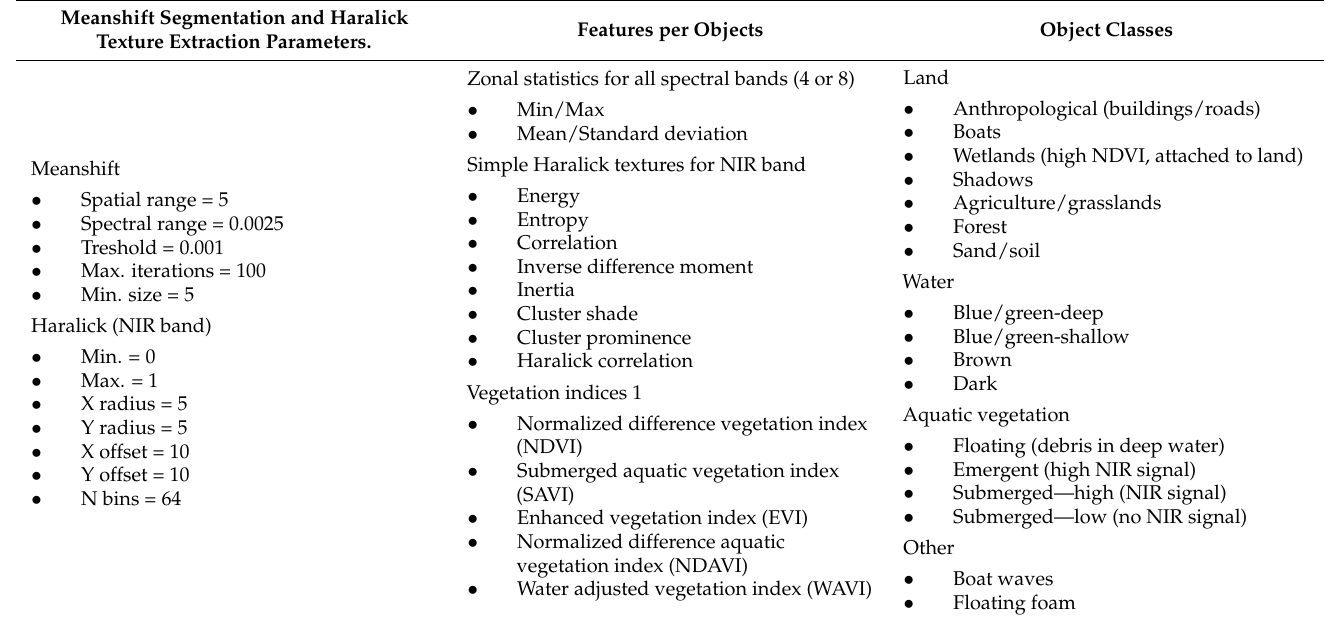
Table 1. Parameters, features and classes used for object-based image analysis level 1 classification (land masking).